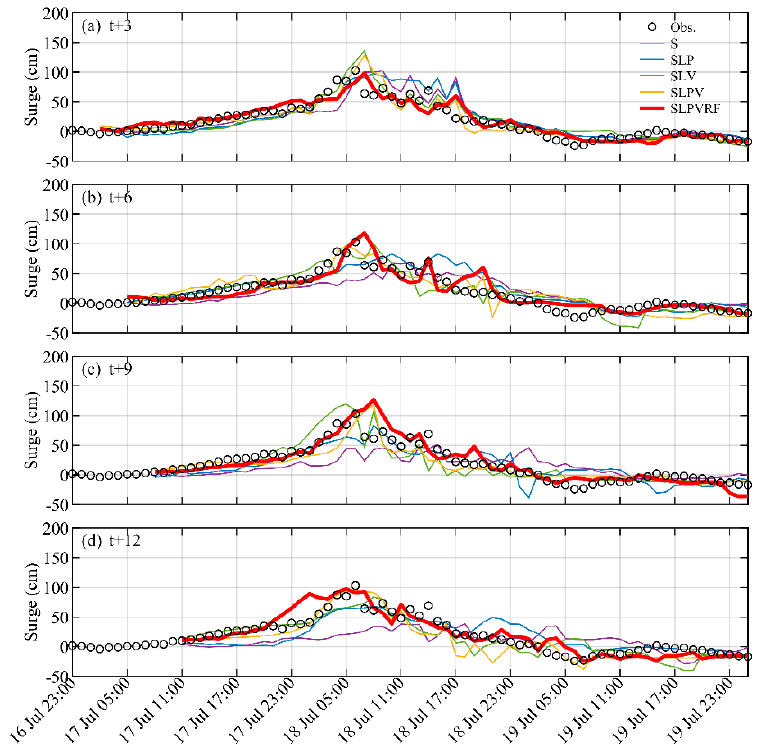
Figure 10. Long-lead-time storm surge predictions obtained by different combinations of controlling parameters for Haitang event (validation): ( a ) t + 3; ( b ) t + 6; ( c ) t + 9; ( d ) t + 12.